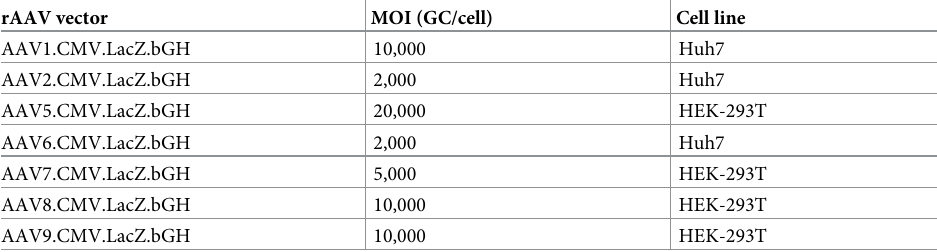
Table 1. List of AAV vectors, multiplicity of infection (MOI) values and cell lines used for the transduction inhibi- tion assay. rAAV vector MOI (GC/cell) Cell line AAV1.CMV.LacZ.bGH 10,000 Huh7 AAV2.CMV.LacZ.bGH Huh7